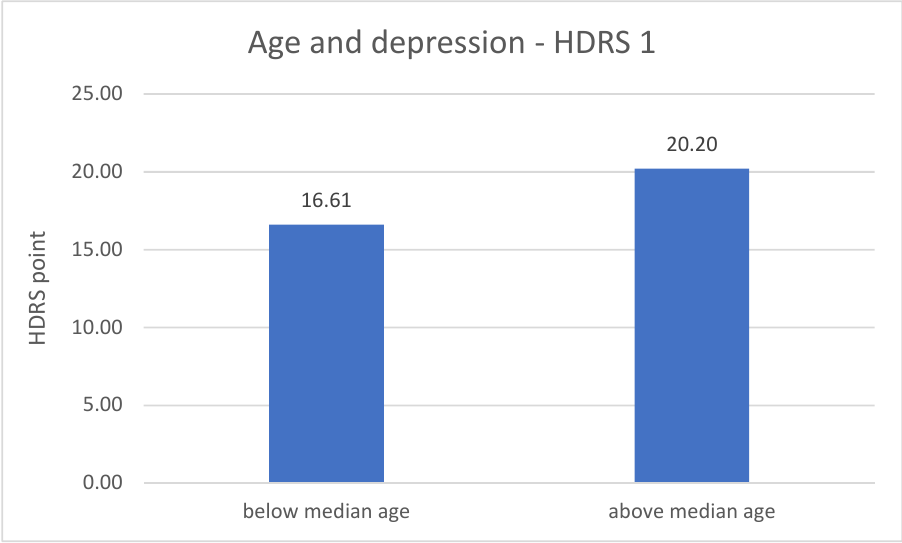
Figure 3. Age and the severity of depression—HDRS 1 measurement.